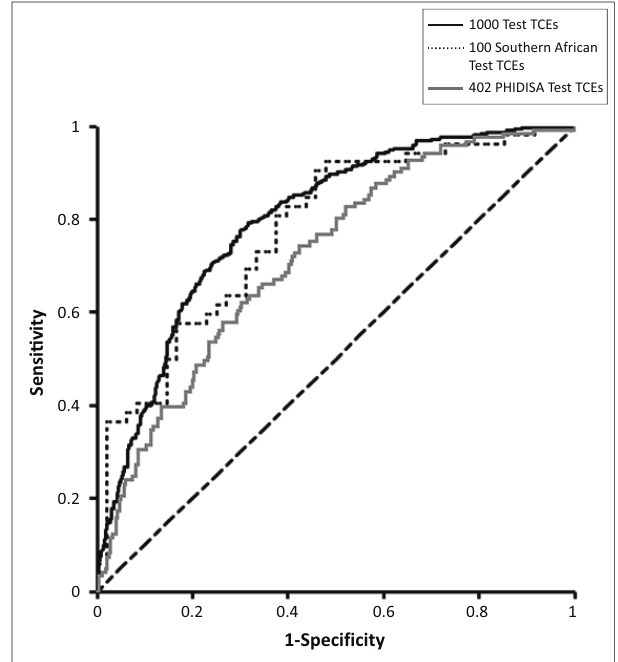
FIGURE 1: ROC curves for the committee of RF models tested with a global test set ( n = 1000), the 100 southern African TCEs from that test set and the Phidisa cases ( N = 402).